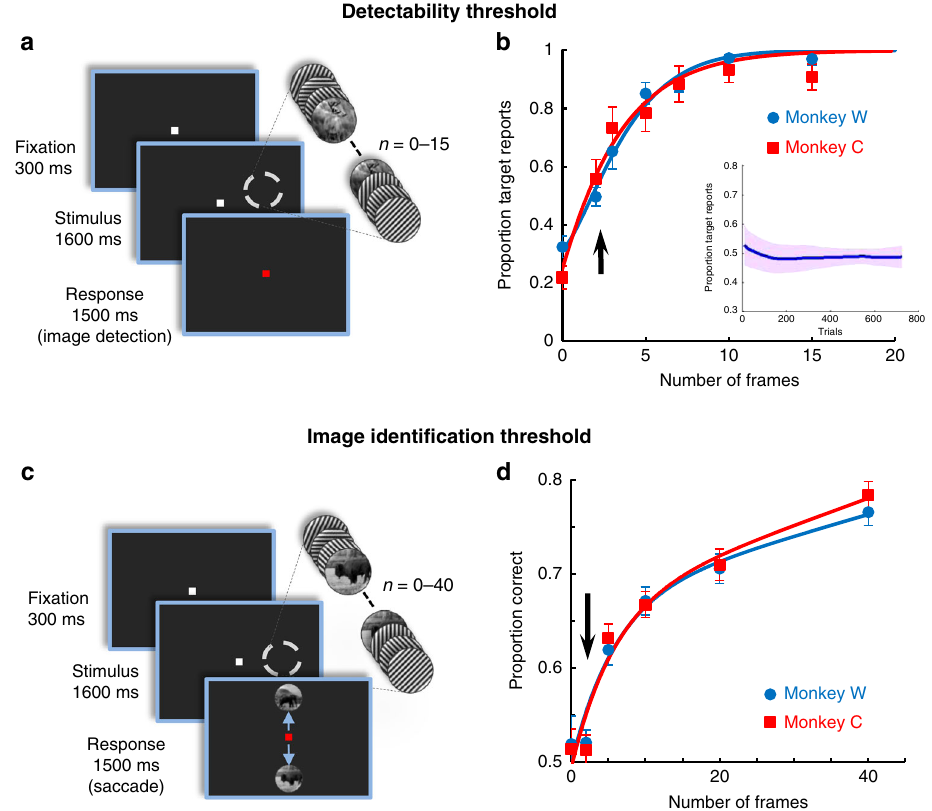
Fig. 1 Behavioral experiments. a Cartoon describing the image detection task — monkeys were trained to report whether a natural image is embedded into a 60-Hz movie stimulus (50% of trials did not contain the image). The image was fl ashed for 2 – 15 consecutive frames inserted at random times with respect to movie onset (total movie length: 96 frames, 1600-ms). b Psychometric curves for the image detection task represented as a function of the number of consecutive image frames. Detection threshold (calculated at d ’ = 1) was 2.89 frames for monkey C and 3.28 frames for monkey W ( n = 16, 6). Inset shows the average detection performance for the two-frame image condition as a function of trials (300 trials moving average, 10 ms step). c